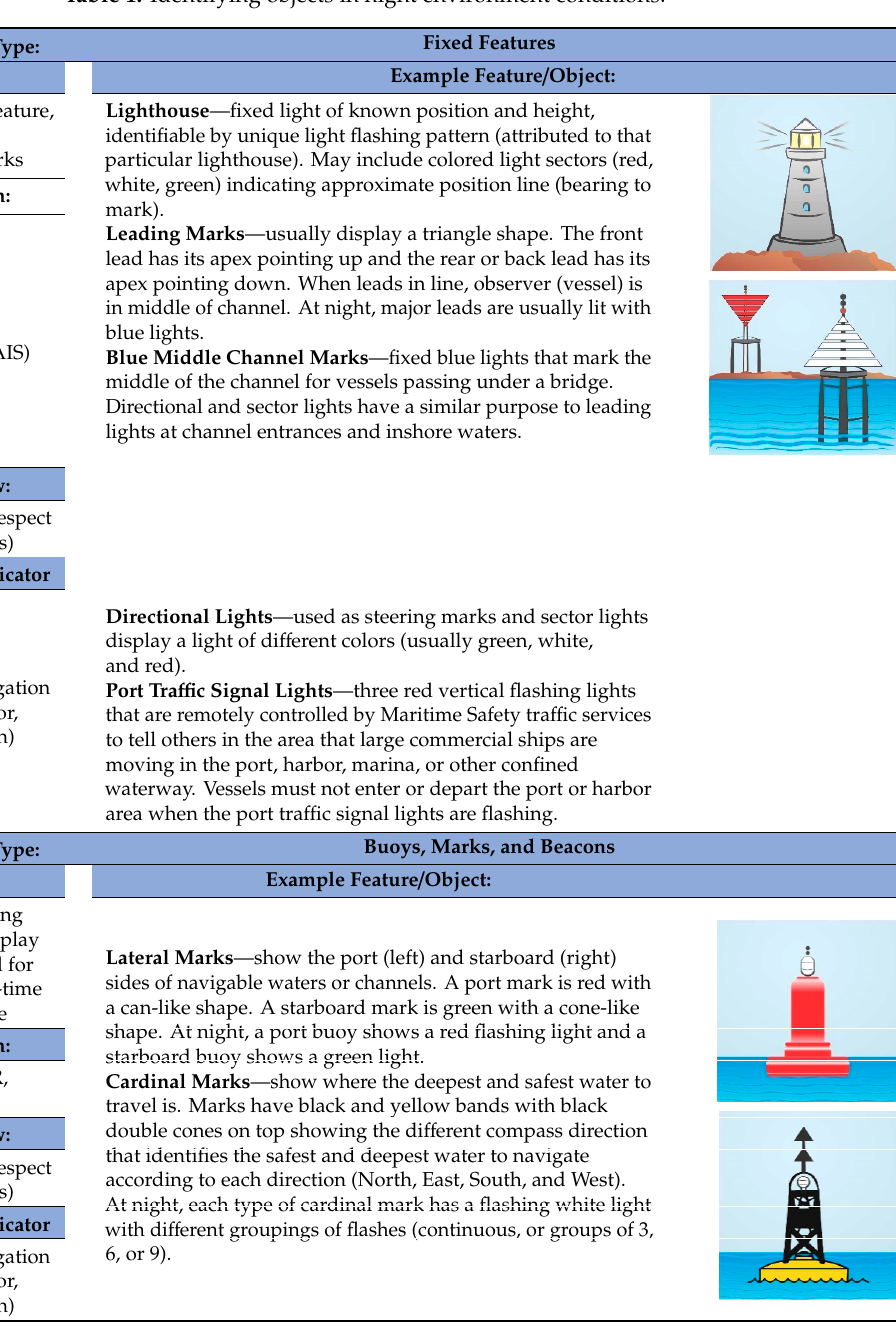
Table 1. Identifying objects in night environment conditions.